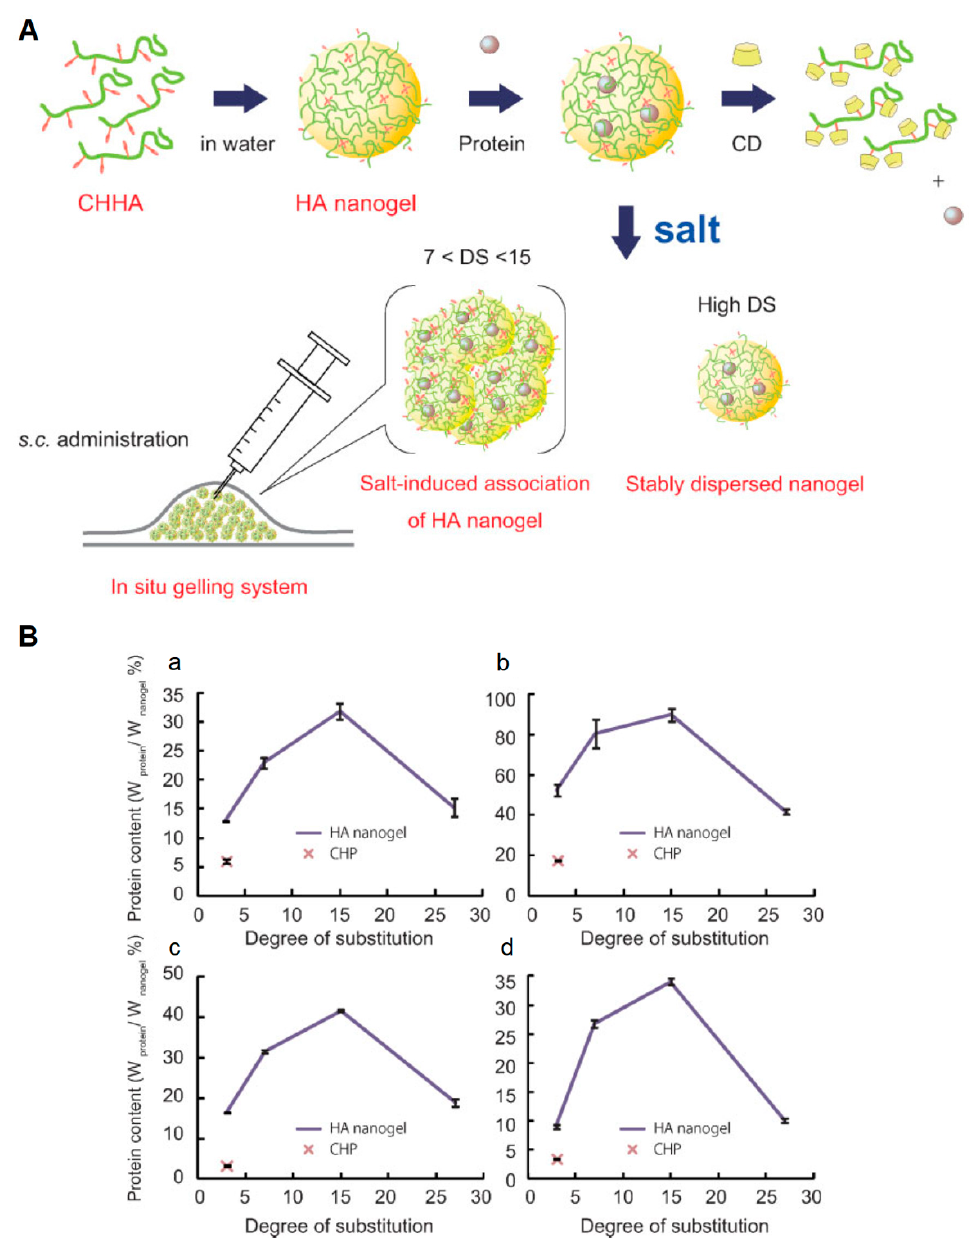
Figure 5. Self-assembling of hyaluronic acid (HA) NGs functionalized with cholesteryl groups. ( A ) Scheme of nanoscaffold design, protein loading and administration. ( B ) Protein-hosting capacity in the proposed NGs, using different payloads: rhGH ( a ), EPO ( b ), lysozyme ( c ) and exendin-4 ( d ). Adapted with permission from Nakai et al. [105]. Copyright (2012) WILEY-VCH Verlag GmbH and Co. KGaA.